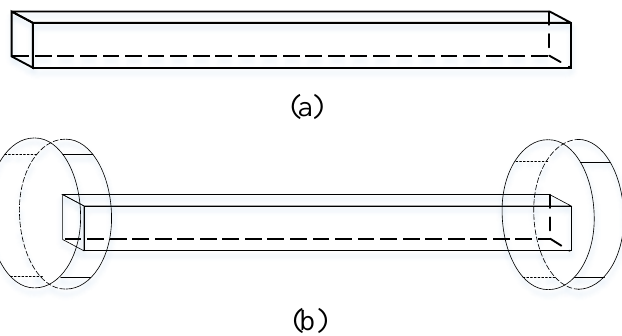
Figure 1. Shape of the core: ( a ) rectangular core and ( b ) rectangular core with flux concentrators.